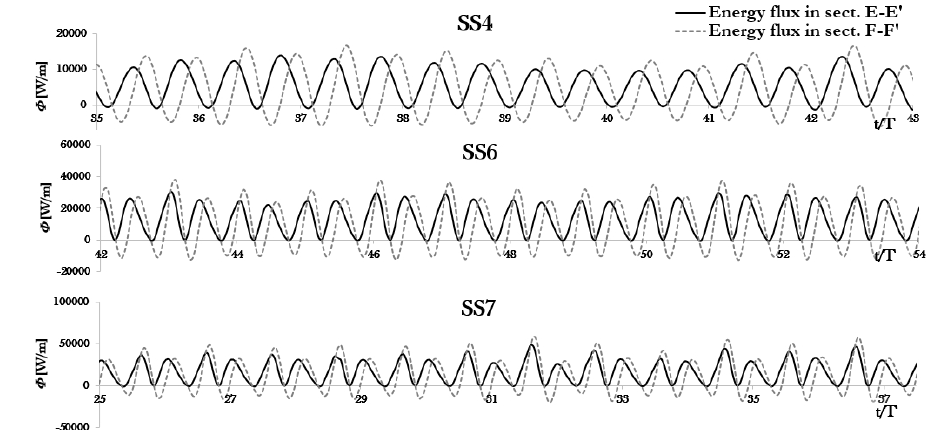
Figure 16. Time histories of the energy fluxes in sect. EE (cid:48) and FF (cid:48)